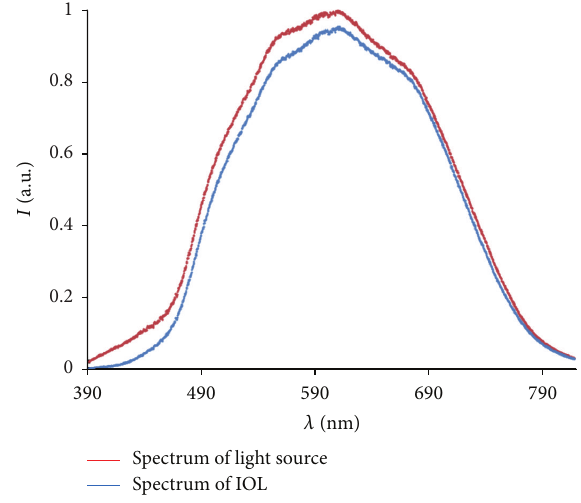
Figure 3: Background-corrected and normalized intensity distribu- tions in the wavelength range from 390 nm to 780 nm for the light source (red) only and an IOL example (Hoya NY60) (blue).